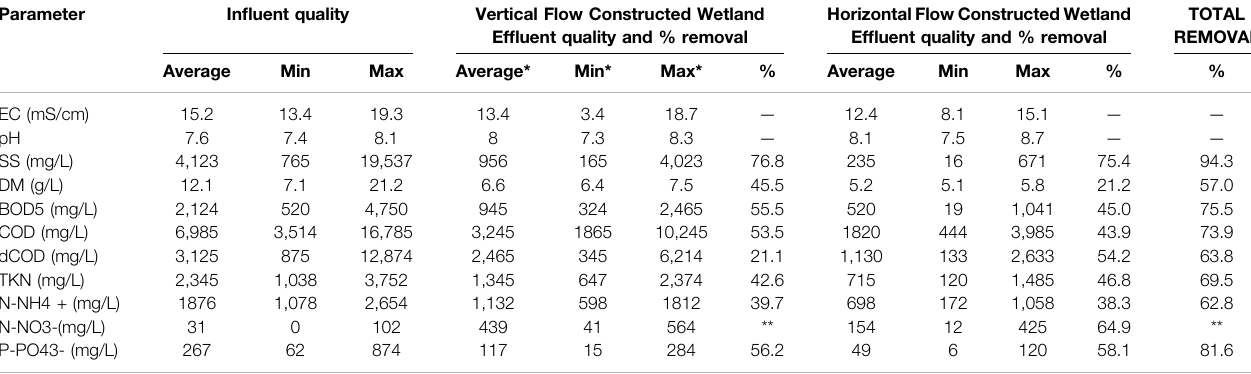
TABLE 3 | Hybrid CW performance: average, maximum and minimum in fl uent and ef fl uent concentration and % removal of pollutants (n (cid:2) 78). Parameter In fl uent quality Vertical Flow Constructed Wetland